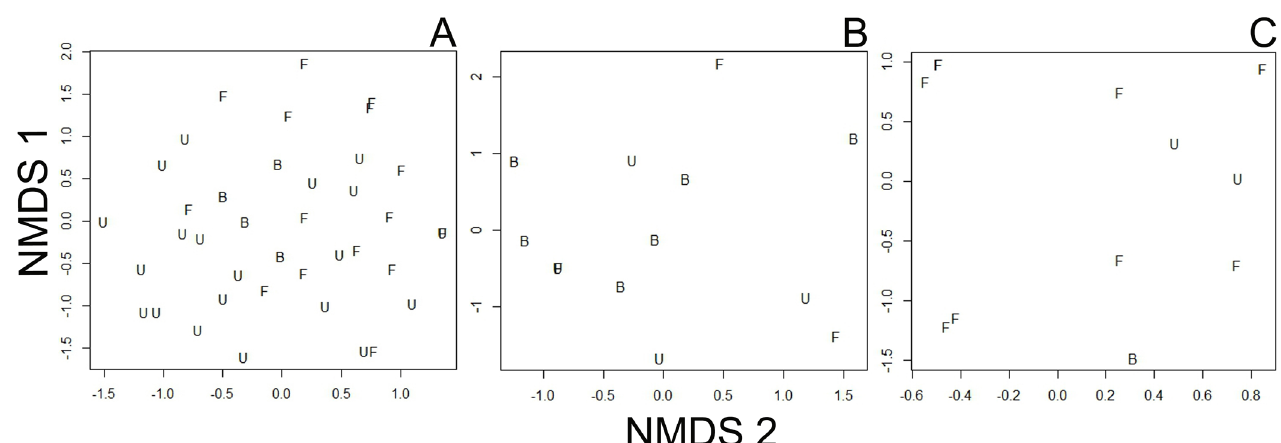
Dissimilarities in species composition in different habitats at the RESEX do Rio Gregório summarized in two Nonmetric Multidimensional Scaling (NMDS) axes for A – amphibians, B – lizards and C – snakes. F = flooded habitats; U = upland habitats; and B = both